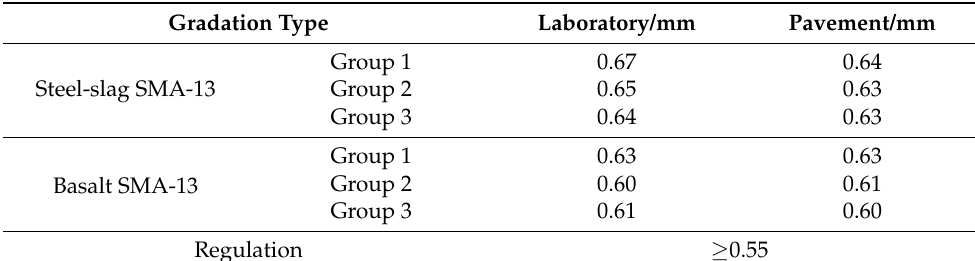
Table 8. The MTD value of both pavements.